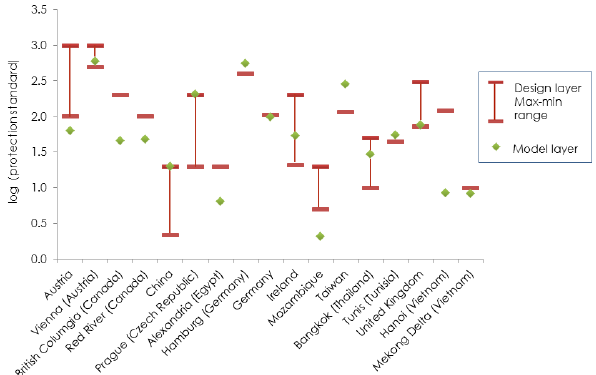
Figure 4. Comparison of the protection standards included in the model layer (green diamonds) to those in the design layer (red bars), for locations where the two layers can be compared on the same scale. For the design layer, a range of values, when available, or a single value are plotted. To enhance the visualisation, values are reported as a logarithm of the protection standard, expressed as the return